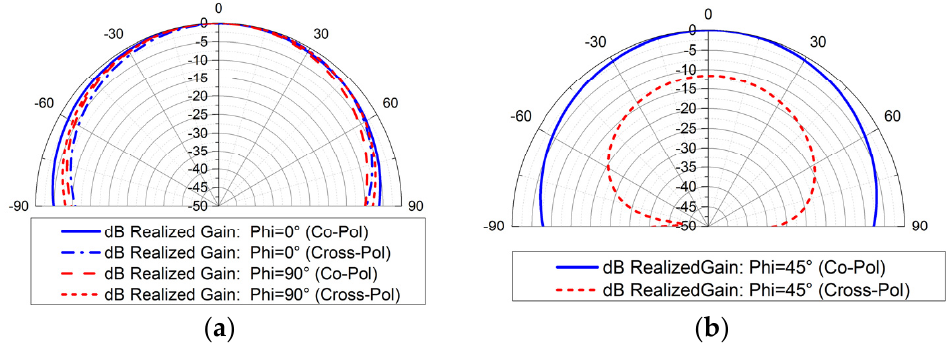
zation; ( b ) in the ON state in a linear polarization.